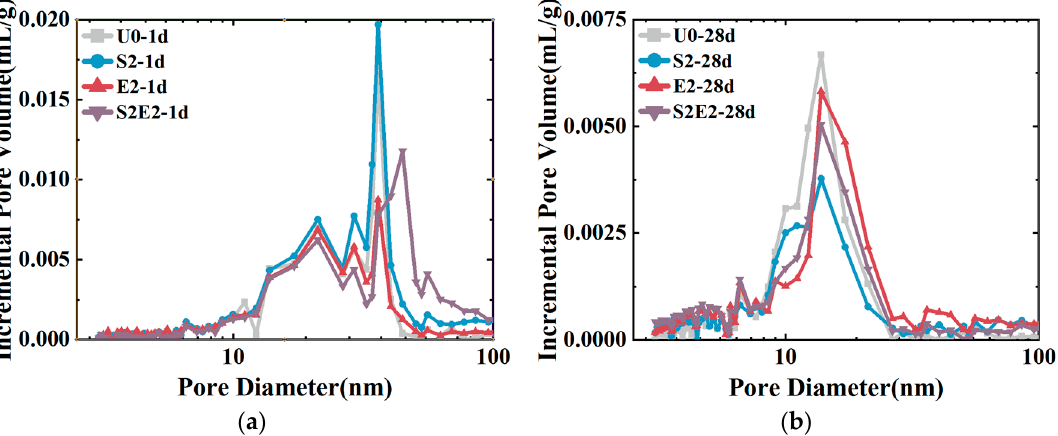
Figure 7. Total porosity of UHPC matrix.